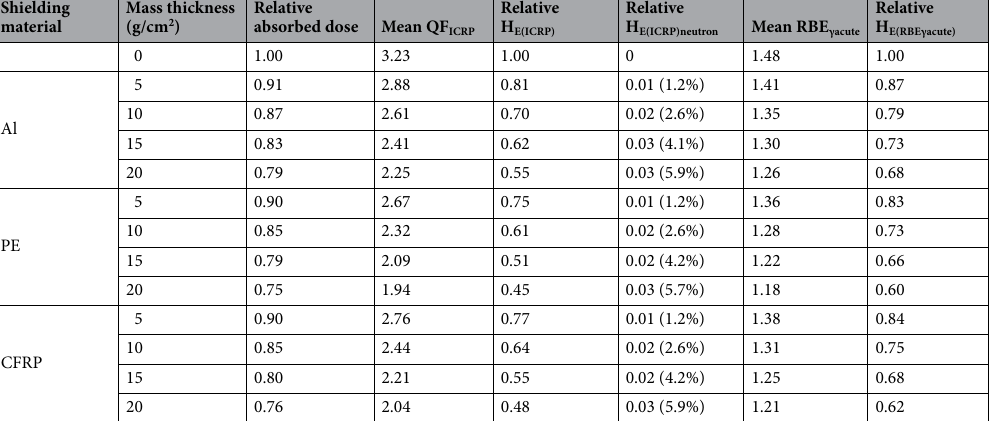
Table 2. Variation of the relative effective dose equivalent, H E , with shielding materials of differing mass thickness. The relative neutron contribution rates (H E(ICRP)neutron ) and contributions to the charged particle contributions (H E(ICRP) ) are